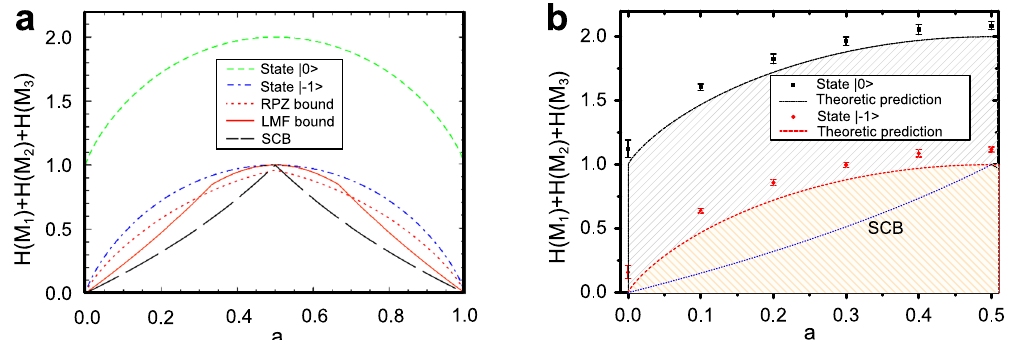
Figure 5. Entropic uncertainty relations for three measurements in the three-dimensional system. ( a ) Comparison between several bounds and entropic uncertainty with respect to a , including the maximal SCB (long-dashed black line), RPZ bound (dotted red line) and LMF bound (solid orange line). Dashed green line is for the theoretic result of state |0 〉 and dashed-dotted blue line is for that of state | − 1 〉 . ( b ) Comparison between the predicted measurement entropy, experiment results and SCB with respect to parameter a . The error bars use the standard error